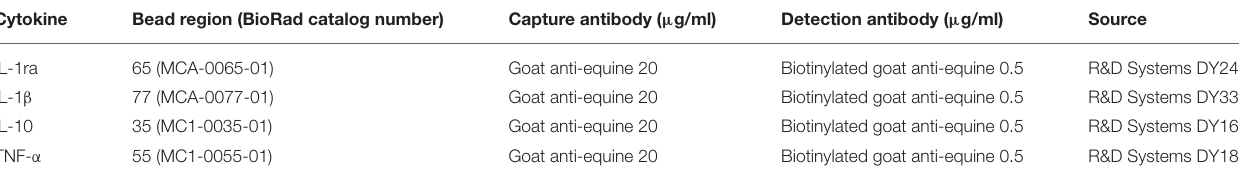
TABLE 1 | Information on capture and detection antibodies used in this study including source and concentration.